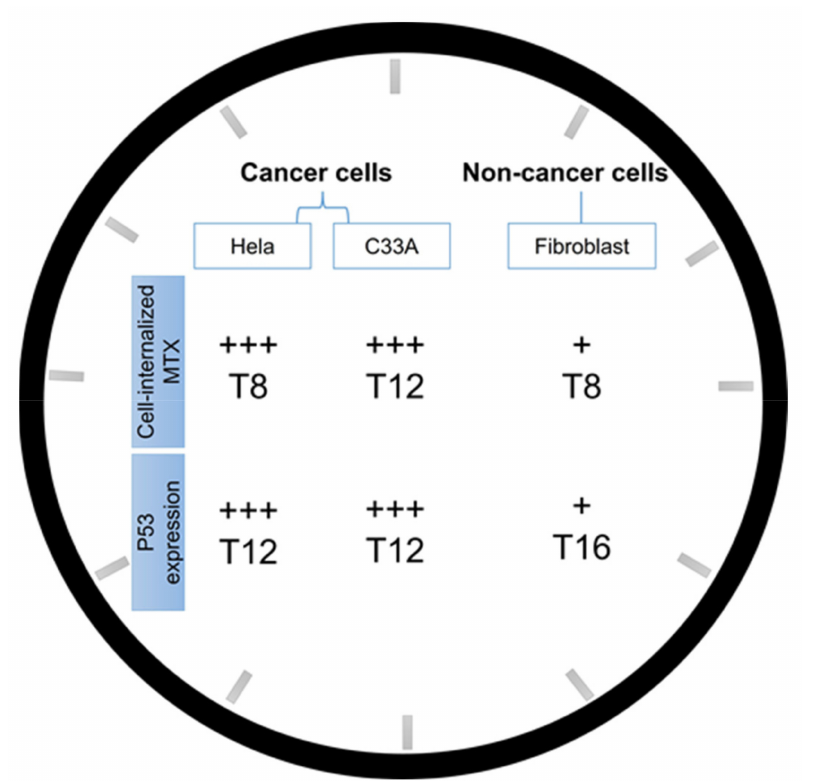
Figure 11. Schematic illustration summarizing the main findings of the current investigation on the influence of circadian rhythm on the performance of PEI/pDNA/MTX nanoparticles. Phenom- ena such as cellular uptake/internalization, cancer-cells targeting or protein expression has been monitored by measuring cell-internalized MTX and p53 protein quantification in HeLa, C33A and fibroblast